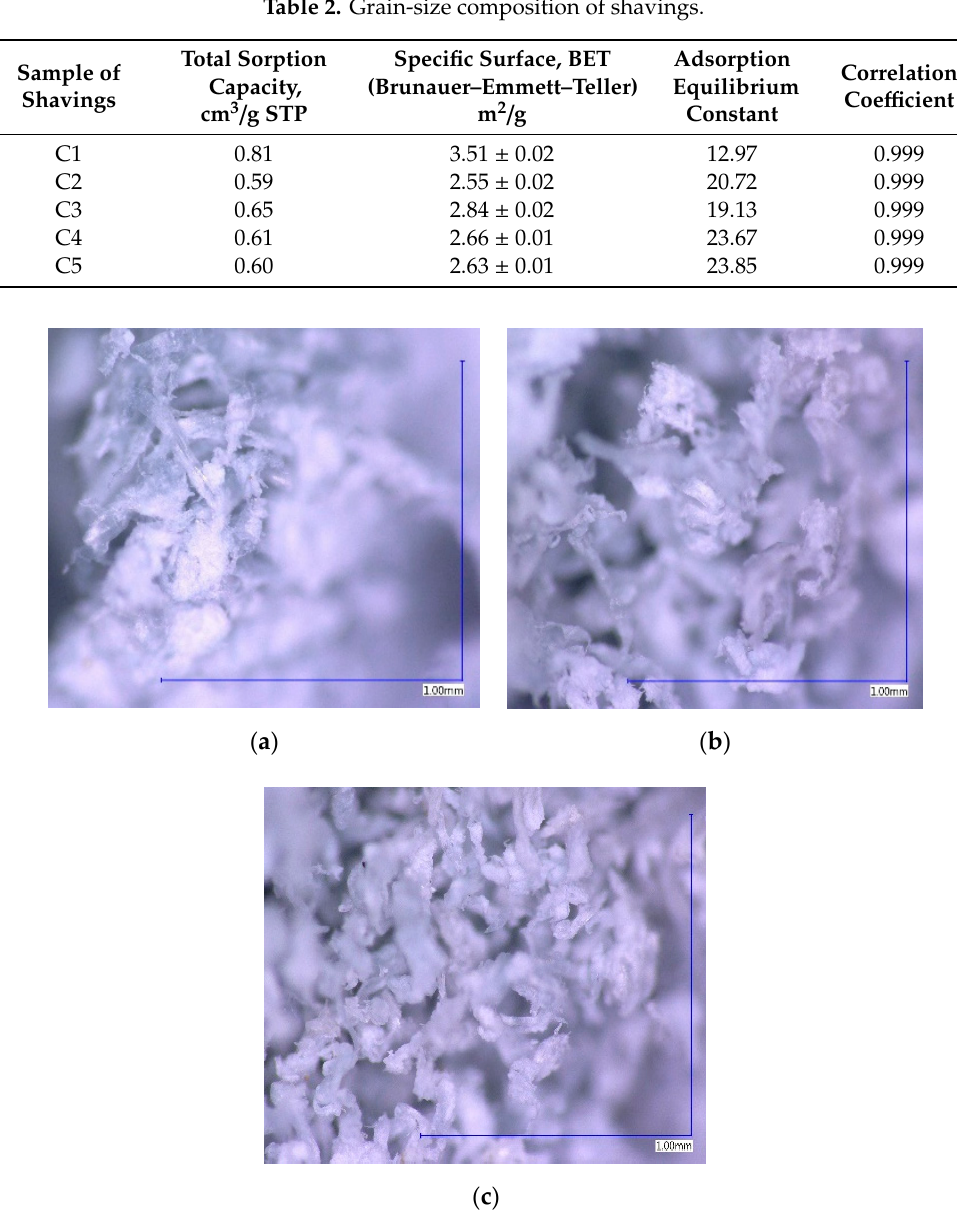
Figure 1. Structure of tanning shavings (( a )—C1, ( b )—C5, and ( c )—C6 fractions).